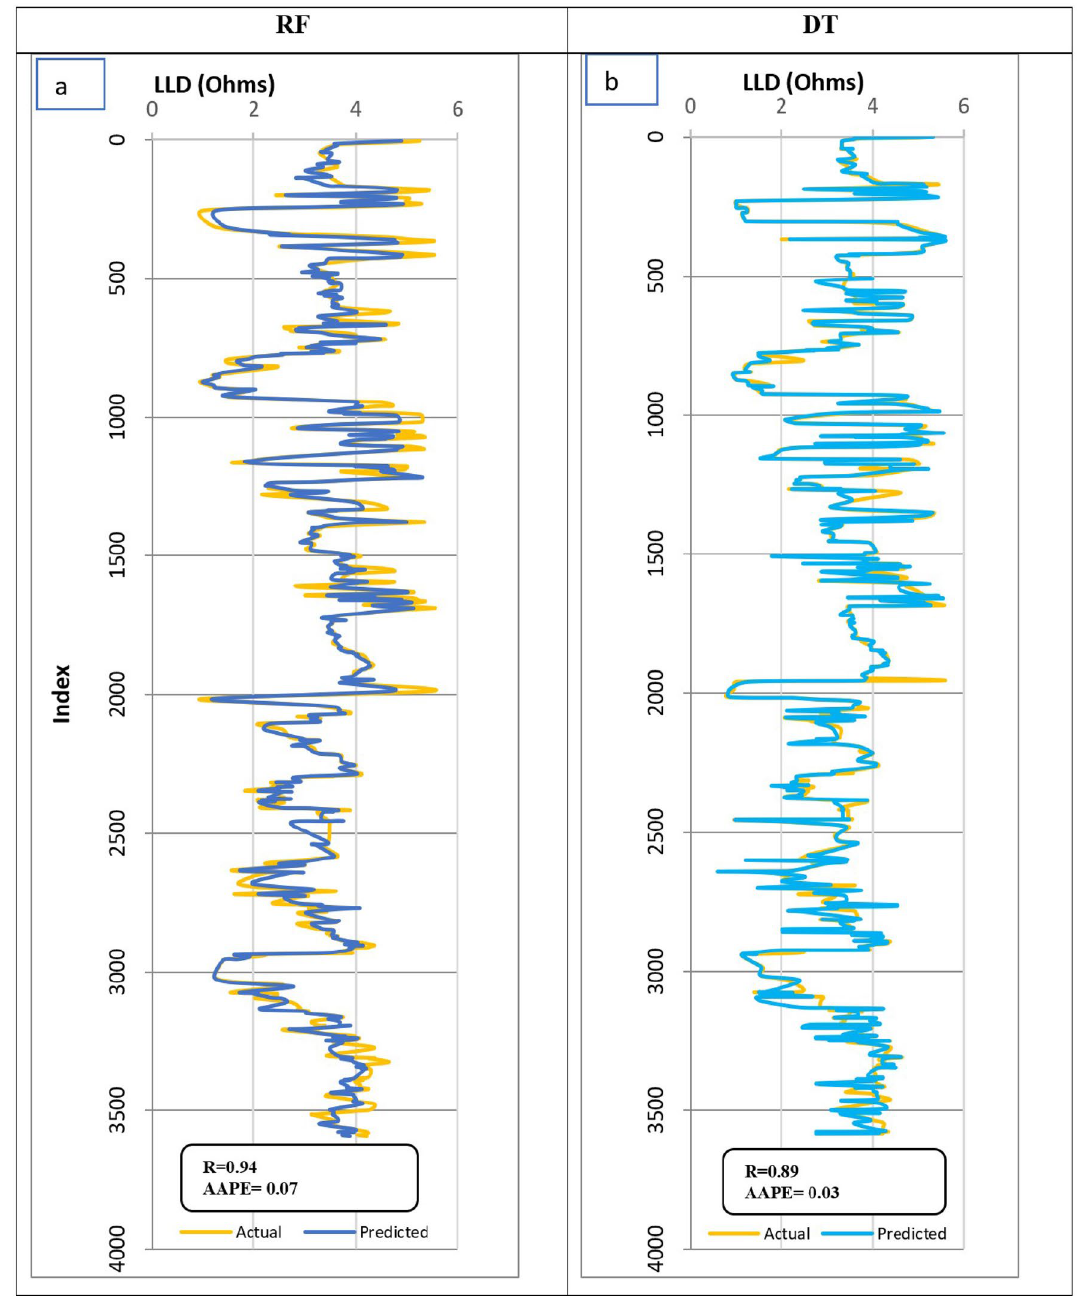
Fig. 4 Actual versus predicted oil well resistivity for the validation stage from a RF and b DT Table 4 Summary of performance indicators of RF and DT models for three stages (training, testing, and